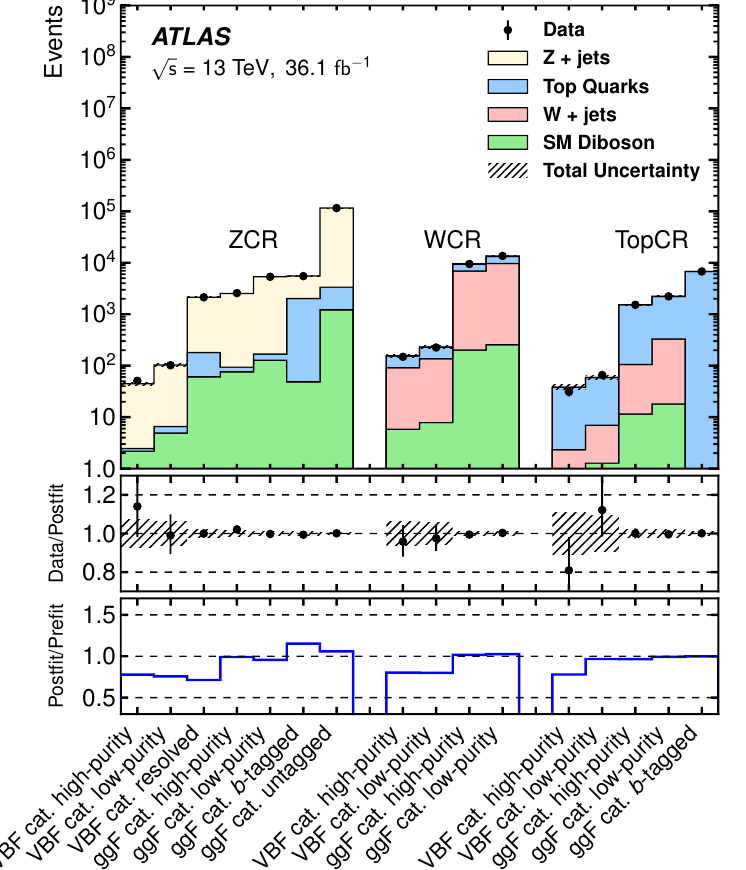
Figure 11 . Comparisons of the observed data and expected background event yields in each control region. The middle pane shows the ratios of the observed data to the post-(cid:12)t background predic- tions. The uncertainty in the total background prediction, shown as bands, combines statistical and systematic contributions. The bottom pane shows the ratios of the post-(cid:12)t and pre-(cid:12)t background